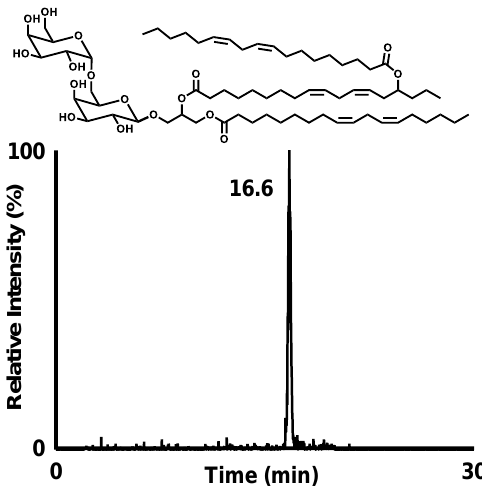
Figure 6. LC-MS/MS analysis of DGDG-LAHLA in the treated cell.